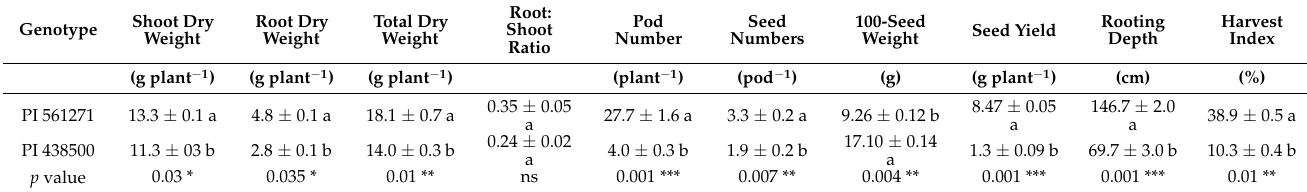
Table 3. Yield and yield-contributing traits of two soybean genotypes (PI 438500, PI 561271) grown in 1.5 m-deep rhizoboxes and harvested 158 days after sowing (DAS). Values are mean ± standard error of three replicates (two plants per rhizobox). Means followed by different letters in each column differ significantly at p < 0.05 using Fisher’s least significant difference. ns: not significant, *, ** and *** indicate significant difference among genotypes at p < 0.05, p < 0.01, and p < 0.001, respectively.